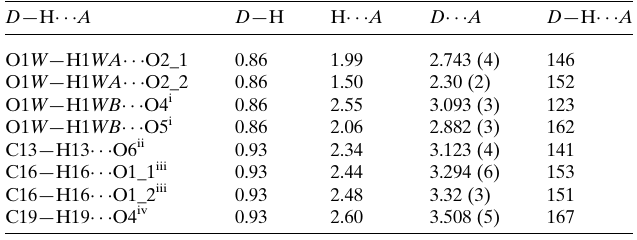
Table 2 Hydrogen-bond geometry (A˚ , (cid:3)